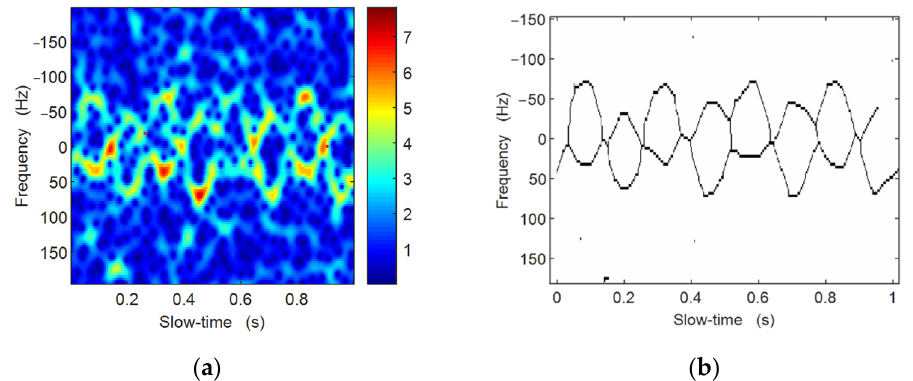
Figure 15. MAPEs of the other four parameters with different normalized error of coning frequency. The anti-noise ability of the proposed method is tested by adding complex Gaussian white noise into the echo signal. When SNR is − 10 dB, the echo micro-Doppler curves and skeletons are shown in Figure 16a,b. The echomicro-Doppler curves are heavily contami- nated by the noise, and the Gaussian spatial mask and binarization operation can no longer effectively suppress noise. The skeletons are not smooth, so the micro-Doppler curves cannot be effectively separated.